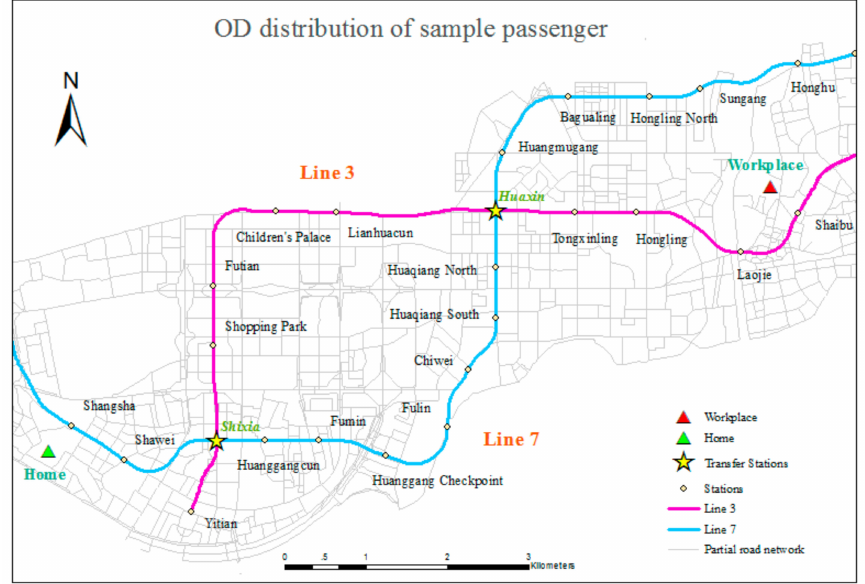
Figure 8. OD distribution of a sample